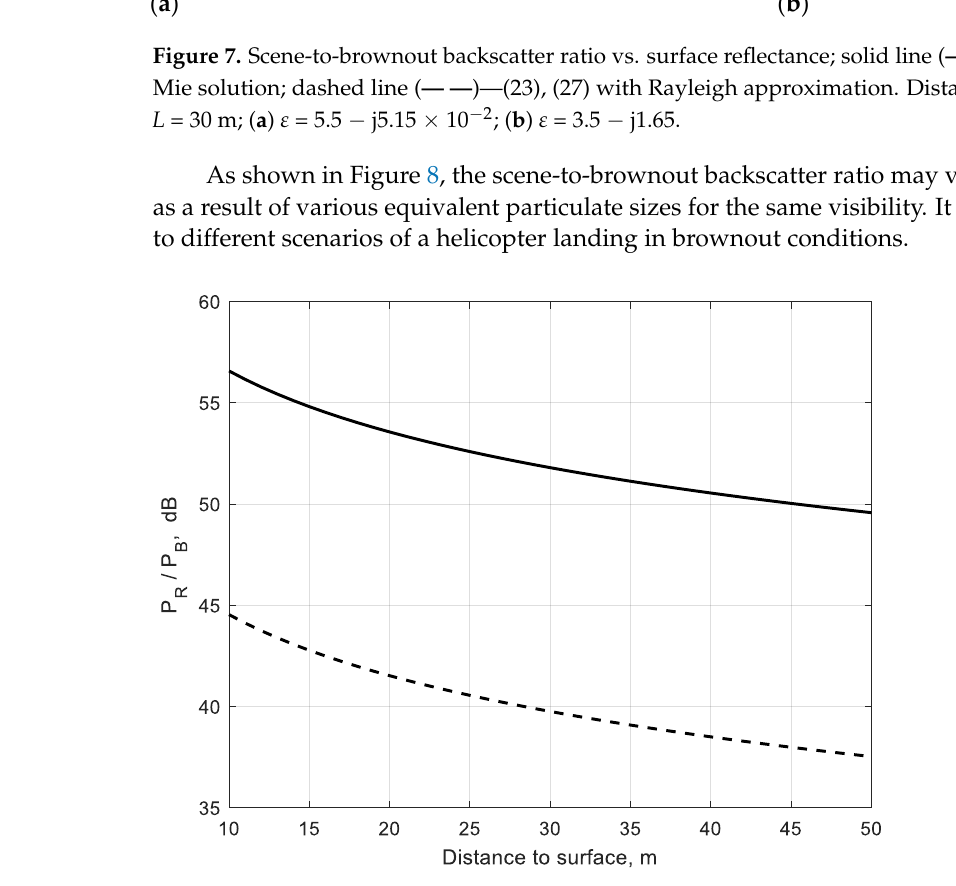
Figure 8. Scene-to-brownout backscatter ratio vs. distance to the surface for different equivalent brownout particles: r e = 15 μm (solid line ― ); r e = 30 μm (dashed line ‒ ‒ ). Surface reflectance ρ = 0.15; ε = 5.5 − j 5.15 × 10 −2 ; Visibility = 10 m.